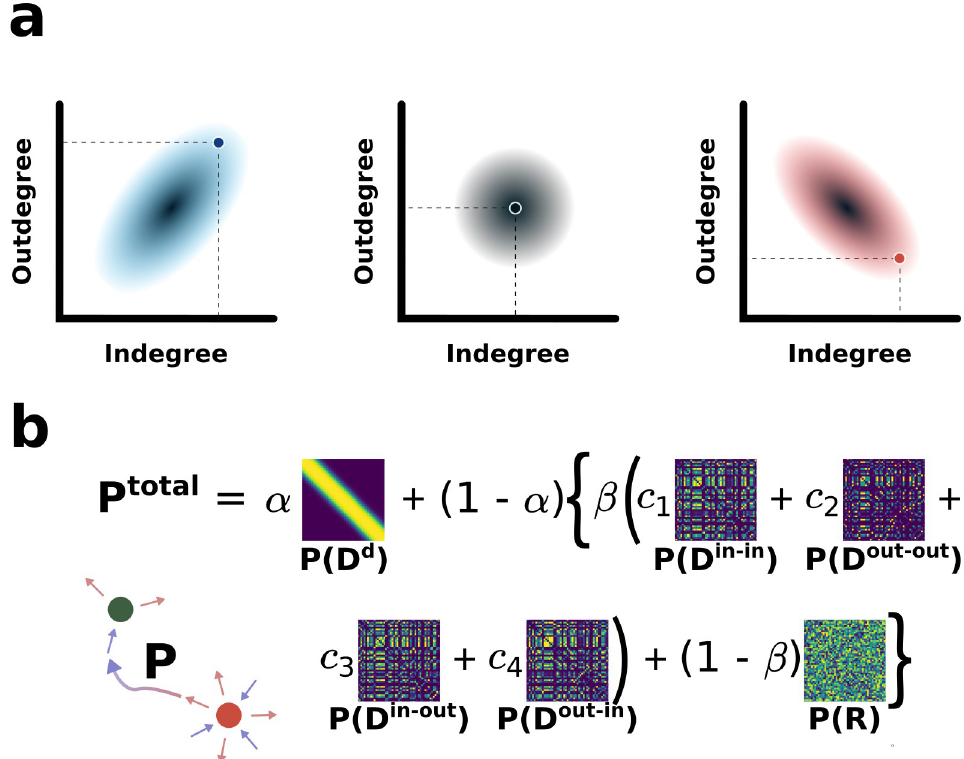
Fig 3. Generating a comprehensive archive of model SCN clock cell-cell networks (schematic illustration). (a) Three different (positive, random, negative) types of k in − k ou correlation. (b) The total connection probability matrix P is a linear combination of P ( D d ), P ( D in-in ), P ( D out-out ), P ( D in-out ), P ( D out-in ), which maximizes the clustering coefficient, k in– k in , k out— k out , k in— k out , and k out— k in assortativity coefficients, respectively, and P ( R ) which is a random connection probability matrix. α , β , c 1 , c 2 , c 3 and c 4 are weighting parameters controlling the relative significance of the involved